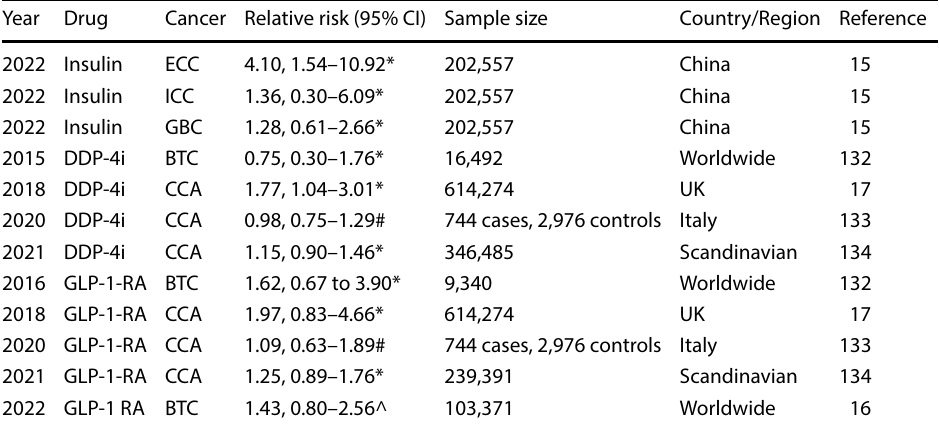
Table 1 Association of insulin and incretin-based drugs with BTC from epidemiological studies